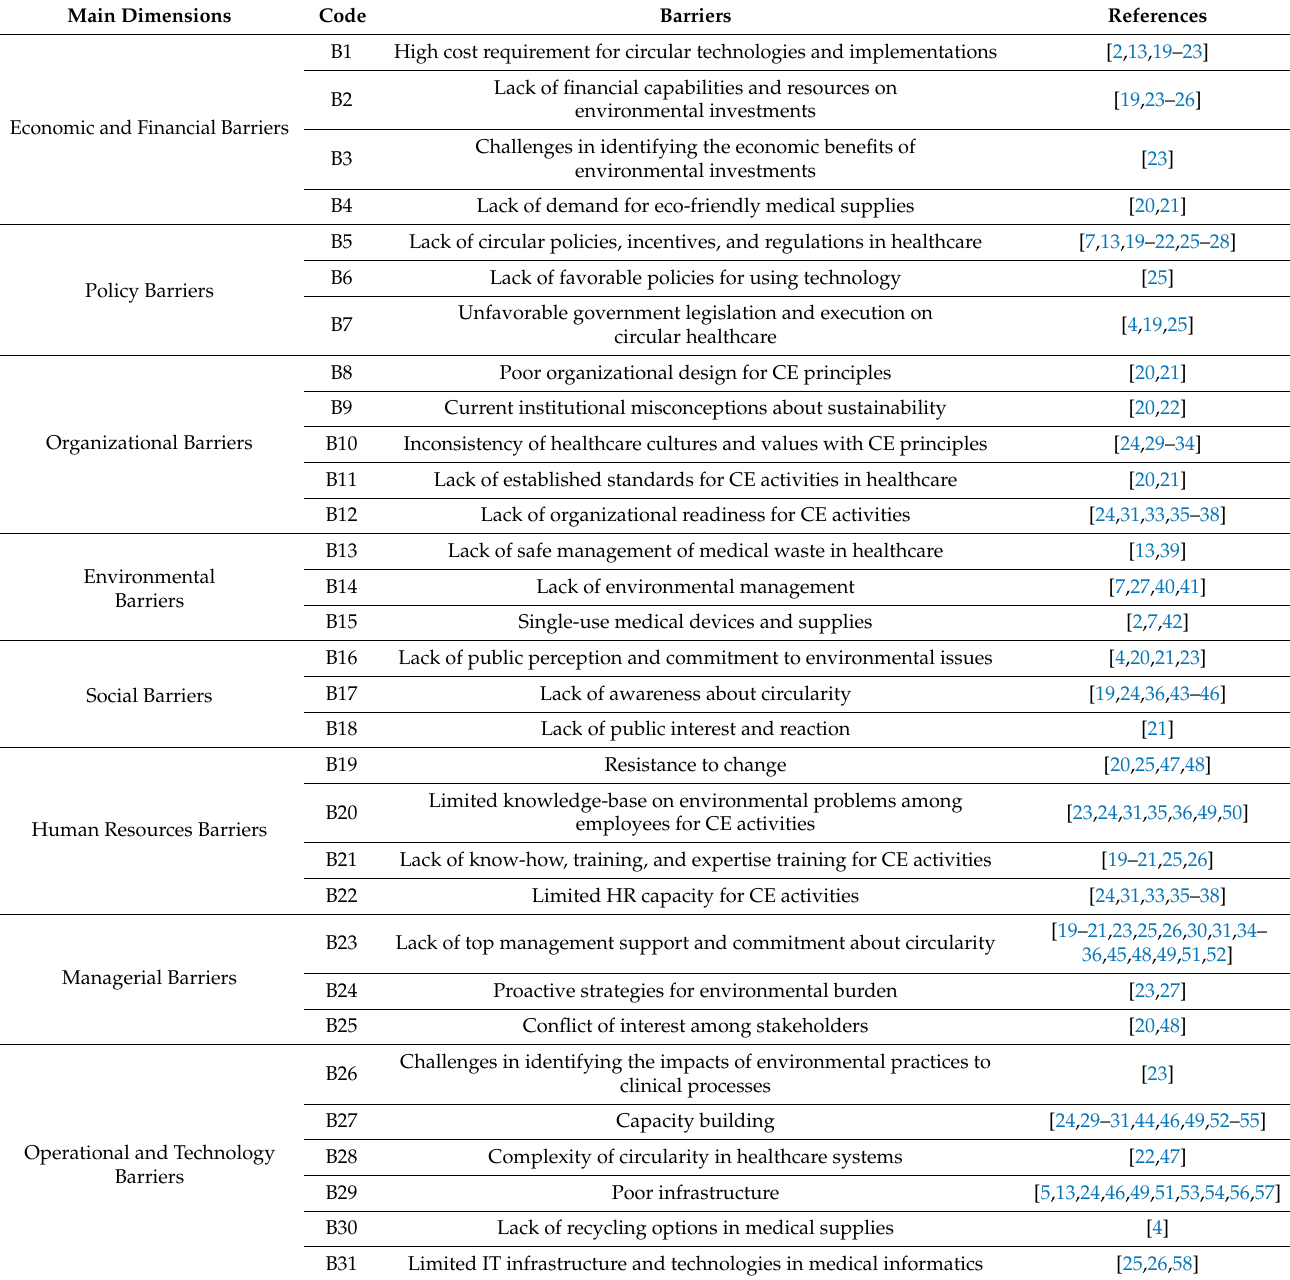
Table 1. Barriers to CE in Healthcare